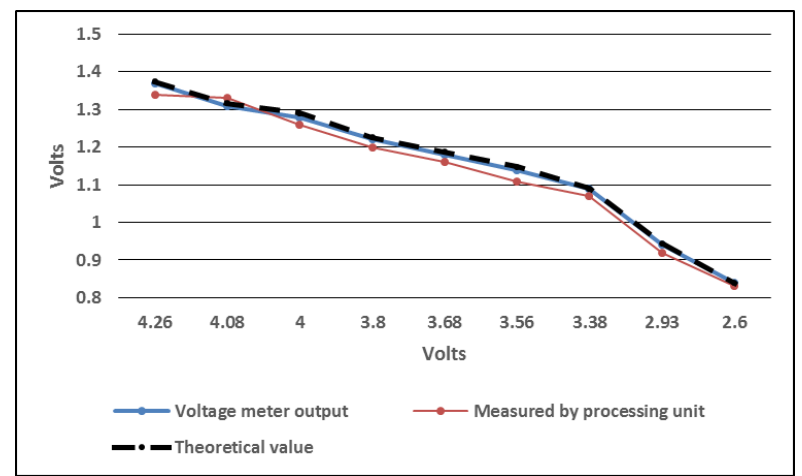
Figure 4. Battery level